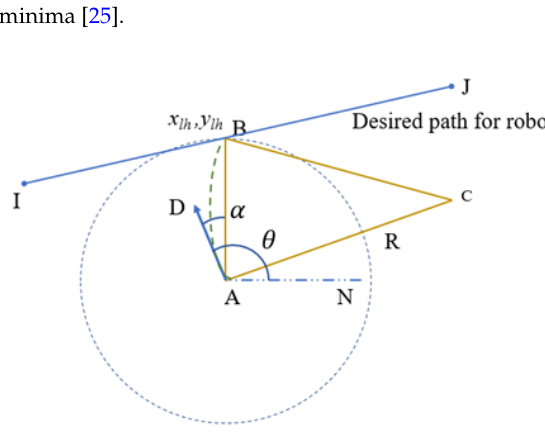
Fig. 1. Conceptual representation of PPA. The PPA algorithm is conceptually depicted in Fig. 1. The lookahead distance between the robot’s position (x,y) and the point of path intersection is lAB (x lh ,y lh ). The LBJ line segment represents the path that the robot should